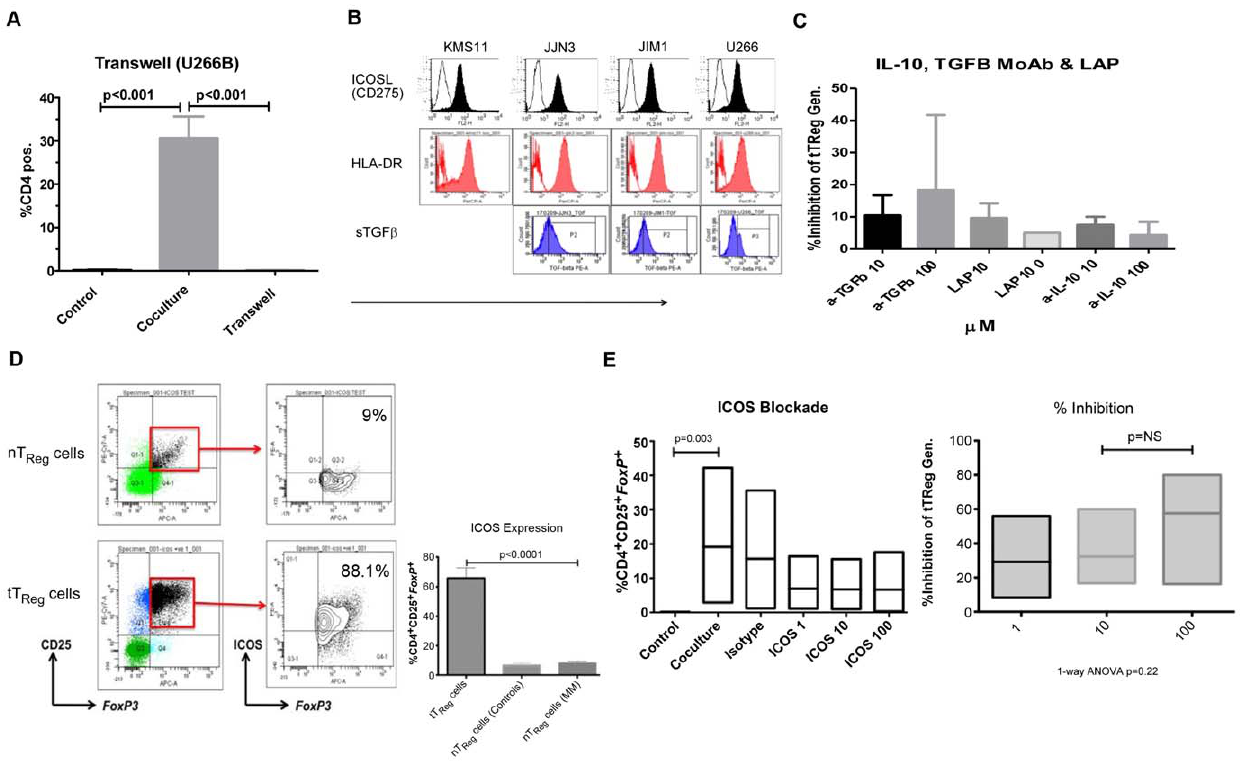
Figure 5. Invitro mechanisms of tumour regulatory T-cell induction. A. The generation of FoxP3 + CD25 + CD4 + tT Reg cells from CD4 + CD25 - T- cells, expressed as a percentage of CD4 + T-cells, in a co-culture assay with mitomycin C-treated U266 cells with and without transwell inserts (n=7). Results represent all experiments, represented as mean 6 SEM and analysed using a student t-Test. B. Surface expression of HLA-DR, ICOSL (CD275) and TGF b by human myeloma cell lines. C. Inhibition of tT Reg cells generation from CD4 + CD25 - T-cells by co-culture with HMCL (n=3) through blockade of TGF b and IL-10 using monoclonal antibodies and Latency-associated Peptide (LAP). Results represent all experiments, expressed as mean ( 6 SEM). D. Surface expression of ICOS by T Reg cells, presented as both percentage expression of CD4 + CD25 + FoxP3 + cells and representative dot plots. Results represent all experiments, expressed as mean 6 SEM (n=3) and analysed using a student t-test. E. Inhibition of tT Reg cells generation from CD4 + CD25 - T-cells by co-culture with HMCL through blockade of anti-ICOS-L ( a ICOS 1, 10, 100 m M) monoclonal antibody (n=6), expressed as percentage of CD4 + T-cells and percent inhibition of tT Reg cell generation. Results represent all experiments, illustrated as median with maximum and minimum values and analysed using a student